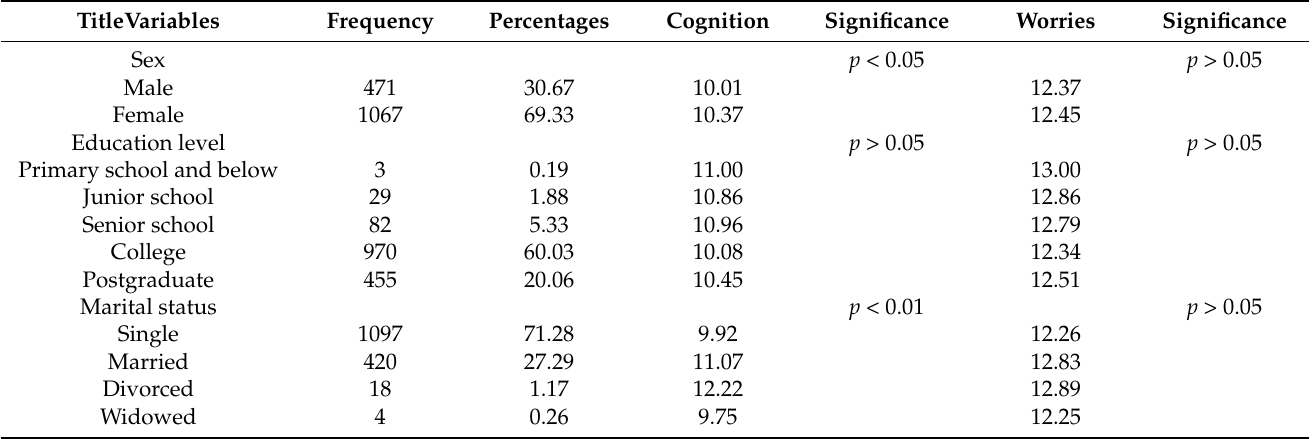
Table 1. Description of the